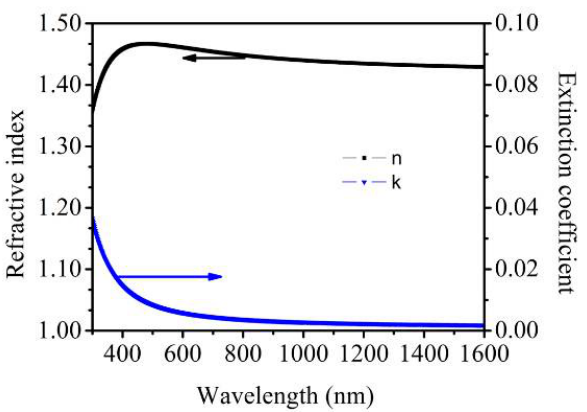
Figure 4. The refractive index ( n ) and extinction coefficient ( k ) of SiO 2 thin film as a function of